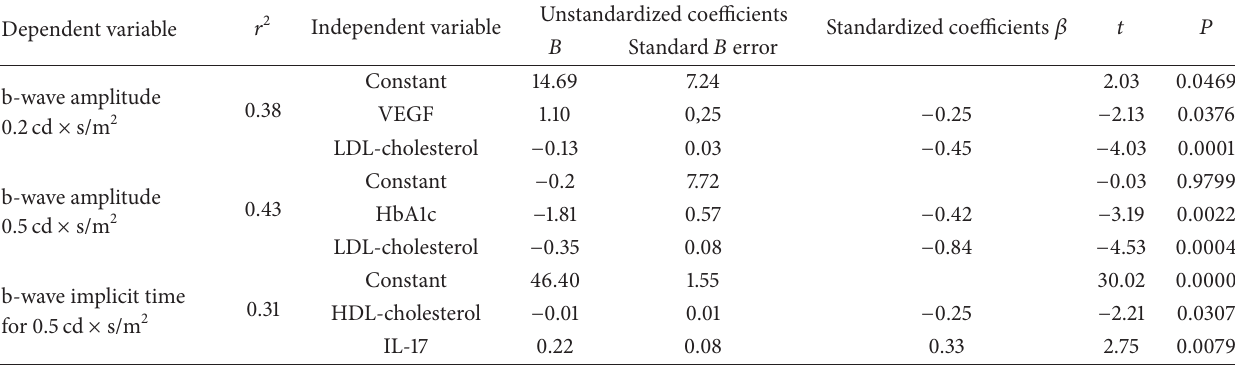
Table 3: Multiple linear regression analyses for b-wave amplitudes for 0.2 cd × s/m 2 , b-wave amplitudes for 0.5 cd × s/m 2 , and b-wave implicit time for 0.5 cd × s/m 2 as dependent